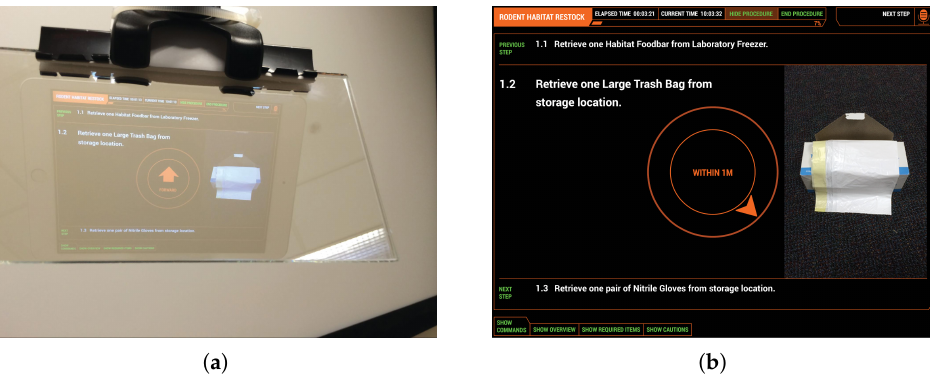
Figure 7. ( a ) AR display reflected from iPad mini running web application onto teleprompter glass in user’s field of view. ( b ) AR user interface displaying the current procedure step with distance and direction of object’s location that the user needs to retrieve. To aid the user, a list of valid verbal commands is also available at the bottom on the user interface, as well as a progress bar of the current procedure at the